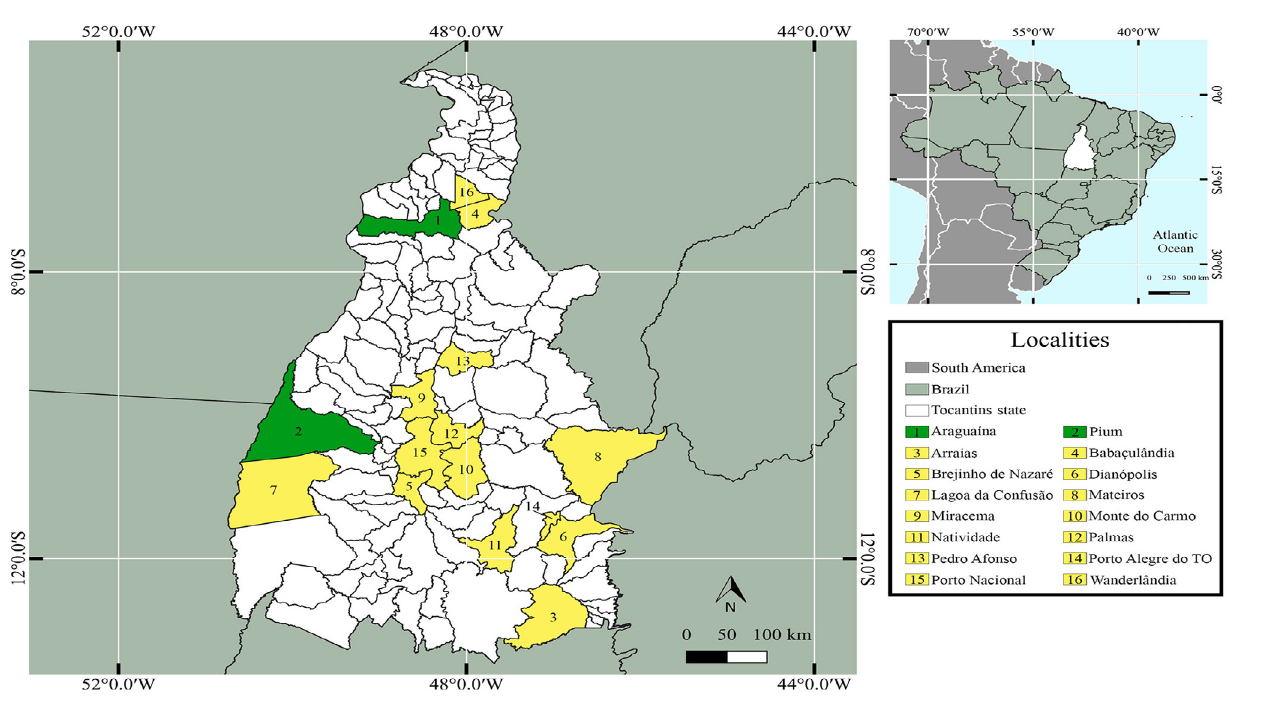
Fig 1 . Map with 16 cities in the Tocantins state: The localities in green have phytophysiognomies predominantly from the Amazon biome, while the localities in yellow have phytophysiognomies from the Cerrado